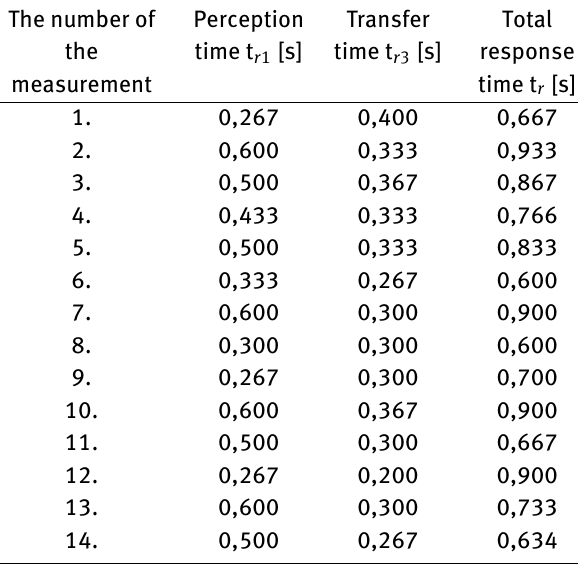
Table 7: Summary of the results of driver B.